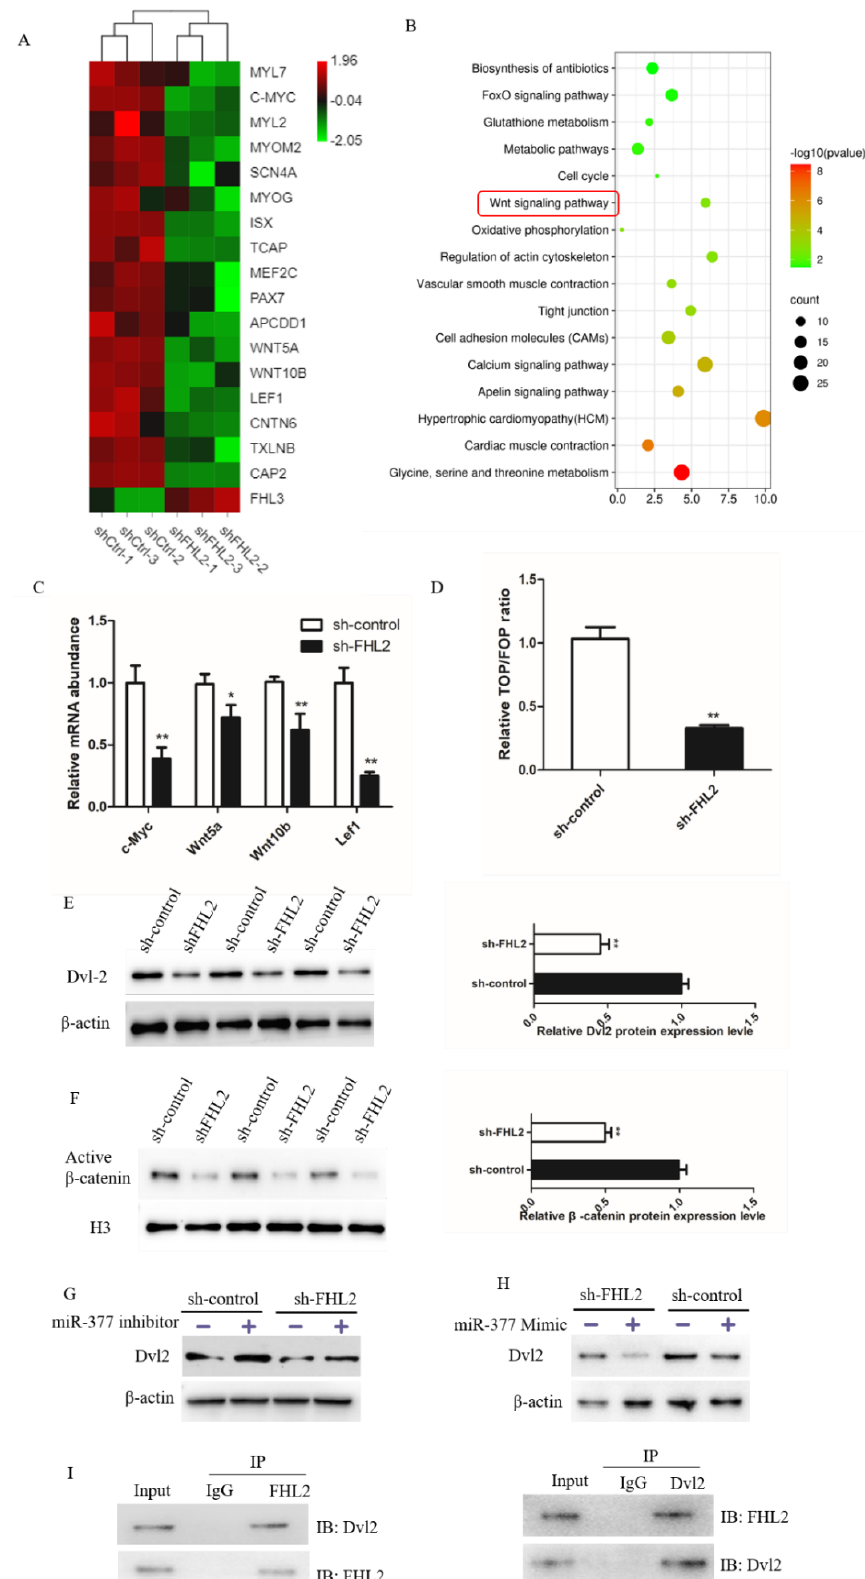
Figure 7. miR-377 negatively regulates Wnt/β-catenin signaling pathway by mediating Dvl-2. ( A ) Grading clustering and heat map of gene expression levels associated with marker myogenesis in SMSCs transfected with control or FHL2 shRNA. ( B ) Enrichment analysis of pathways with significantly differentially expressed genes in sh-ctrl and FHL2 silenced cells. ( C ) Relative